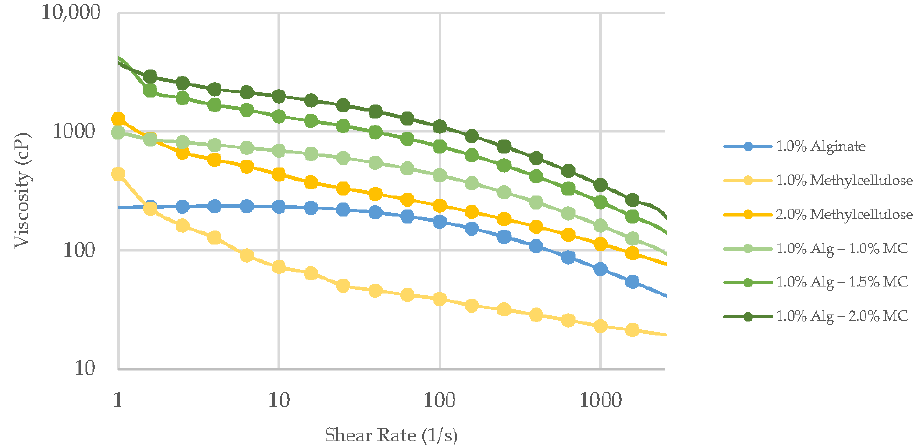
Figure 3. The viscosity vs. shear rate behavior of alginate (blue), methylcellulose (yellow), and mixtures of the two (green) with varying methylcellulose concentration (% w/v ). The circular symbols appearing in the plots represent the mean-values of discrete measurements evenly acquired at logarithmic intervals under steady-state conditions, while the continuous lines are guides for the eye. MC: methylcellulose; Alg: alginate.